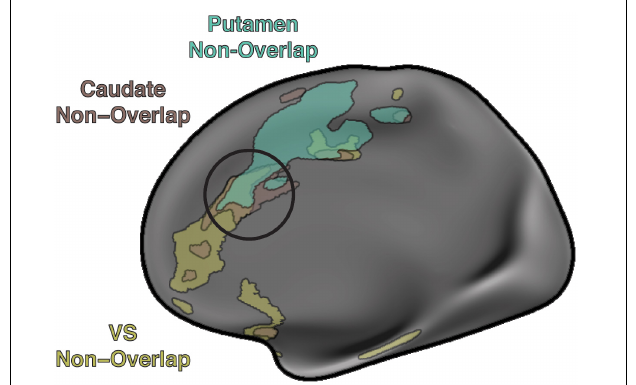
FIGURE 3 | Cortical resting state functional coupling of the non-overlapping clusters. The putamen non-overlap cluster shows functional connectivity to the supplementary motor area and anterior cingulate cortex, the caudate non-overlap cluster shows functional connectivity to the anterior cingulate cortex, the VS non-overlap cluster show functional connectivity to the ventromedial prefrontal cortex and anterior cingulate cortex. A trilateral intersection of functional coupling is observed in the anterior cingulate cortex (black circle) possibly indicating a locus of integration among attentional (caudate), motivational (VS), and motor (putamen) component